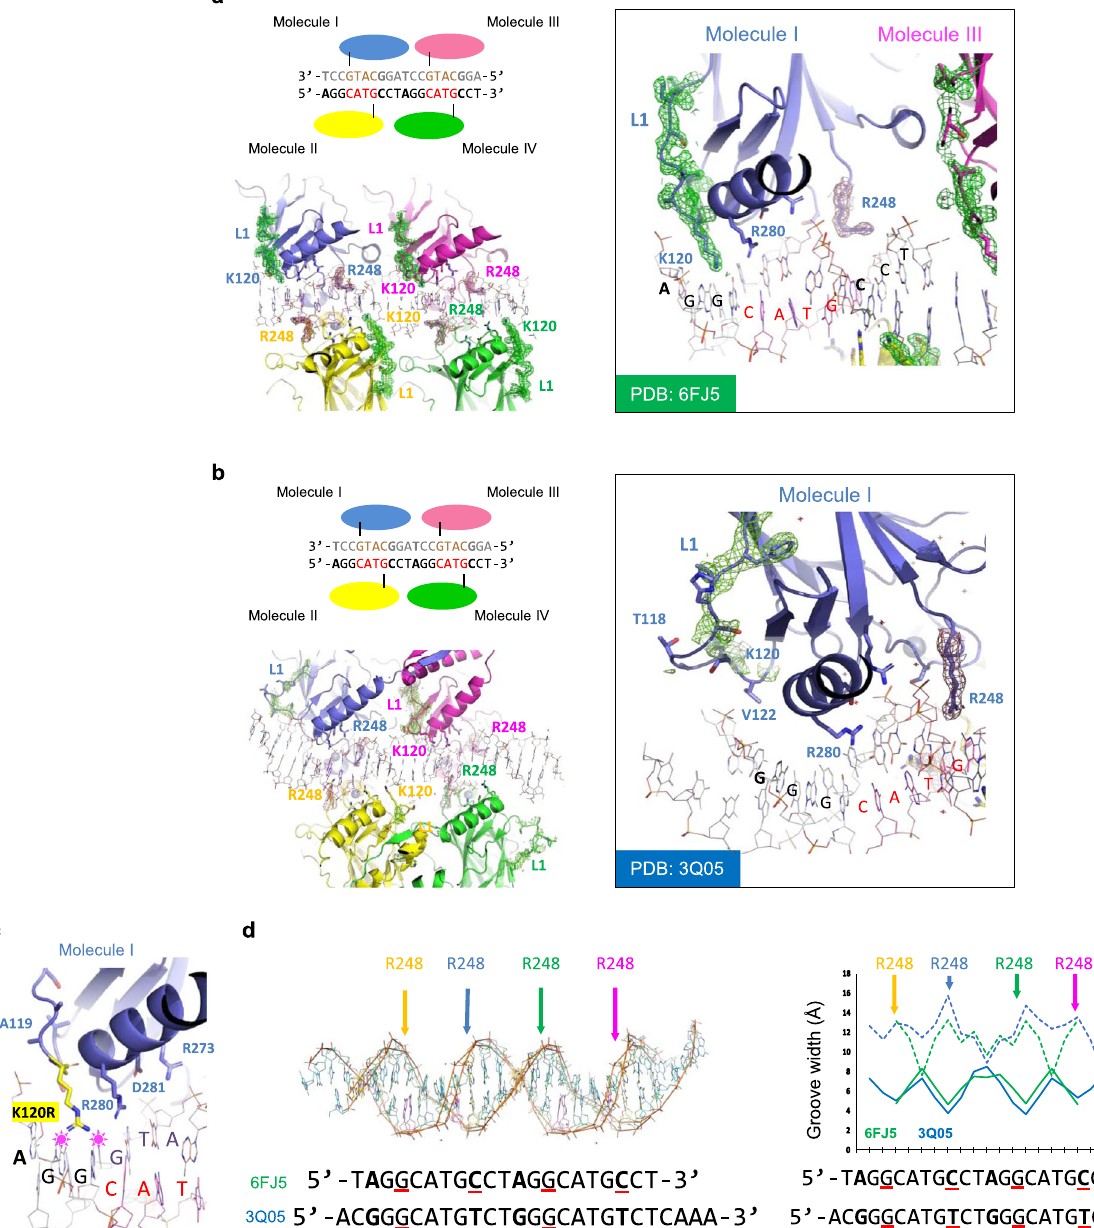
Fig. 3 Structural analysis of p53 in complex with distinct REs. a , b Binding modes of p53 in complex with low-af fi nity, K120R-unbound ( a ) and high- af fi nity, K120R-bound RE ( b ). Top left: schematic representation of tetrameric p53 and DNA interactions. The CWWG core motifs are highlighted in red or gold. The four Arg280 residues of tetrameric p53 (molecules I to IV) that interact with guanine of the CWWG core regions are marked as black lines. DNA sequence differences between 6FJ5 23 ( a ) and 3Q05 14 ( b ) are shown in bold (positions 1, 8, 11, and 18). Lower left: overview of the p53 structure in complex with the respective RE. The 2F o – F c electron density map contoured at 1 σ above the mean is shown for the L1 loops in green and for the Arg248 residues in brown. Right: detailed view of molecule I-DNA interactions. c Modeling the Lys120 to Arg (K120R) mutation in the binding mode of low-af fi nity, K120R- unbound REs suggests steric clashes, indicated by pink stars with two guanine bases at positions 2 and 3. d Left: superimposition of the DNAs of 6FJ5 (green) and 3Q05 (blue). Arrows indicate signi fi cant differences between the two DNA structures and the approximate positions of the Arg248 residues colored as in a and b sensing the minor groove width. The aligned sequences are shown on the bottom, with differences in the 20-bp regions highlighted in bold, and positions 3, 8, 13, and 18 underlined in red. Right: width of major (dashed) and minor grooves (solid) calculated by the program 3DNA 47,48 . The plotted points correspond to positions between bps. Source data are provided as a Source Data fi